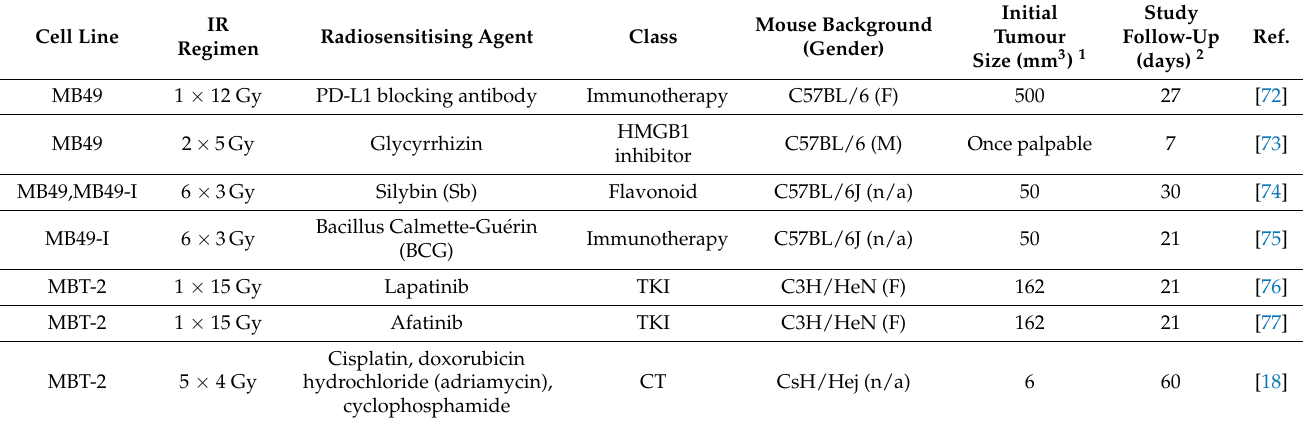
Table 4. Overview of mouse BCa syngeneic models used in radiosensitisation studies.